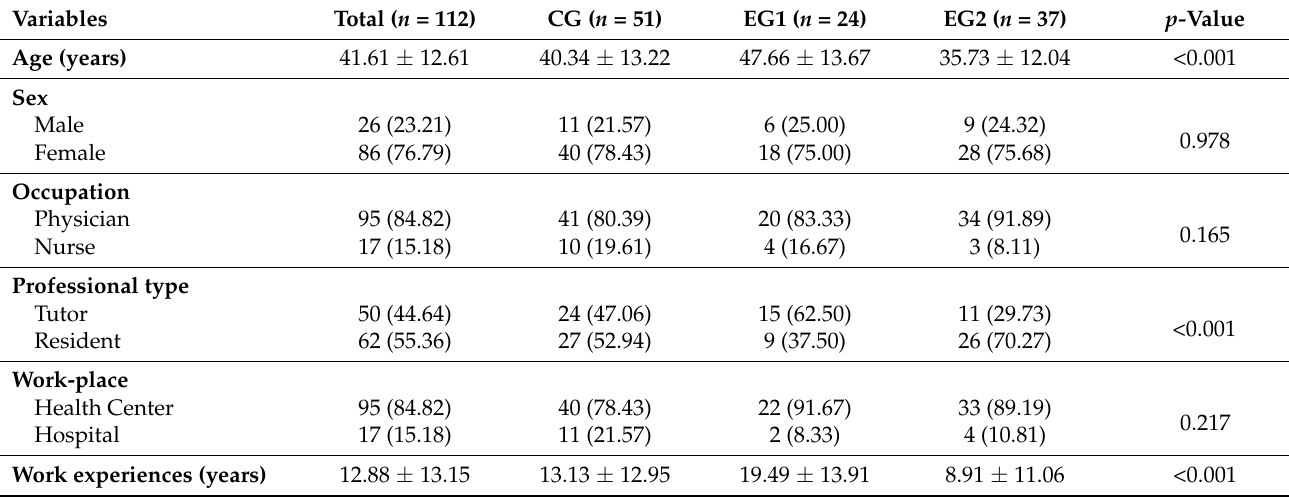
Table 1. Baseline characteristics of